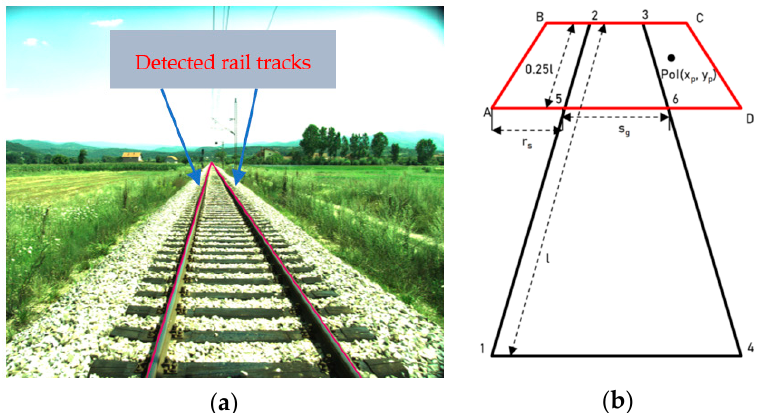
Figure 4. ( a ) Detected rail tracks represented by red lines overlaying the original image. ( b ) Illustra- tion of region of intrusion (RoI) definition (red trapezoid).